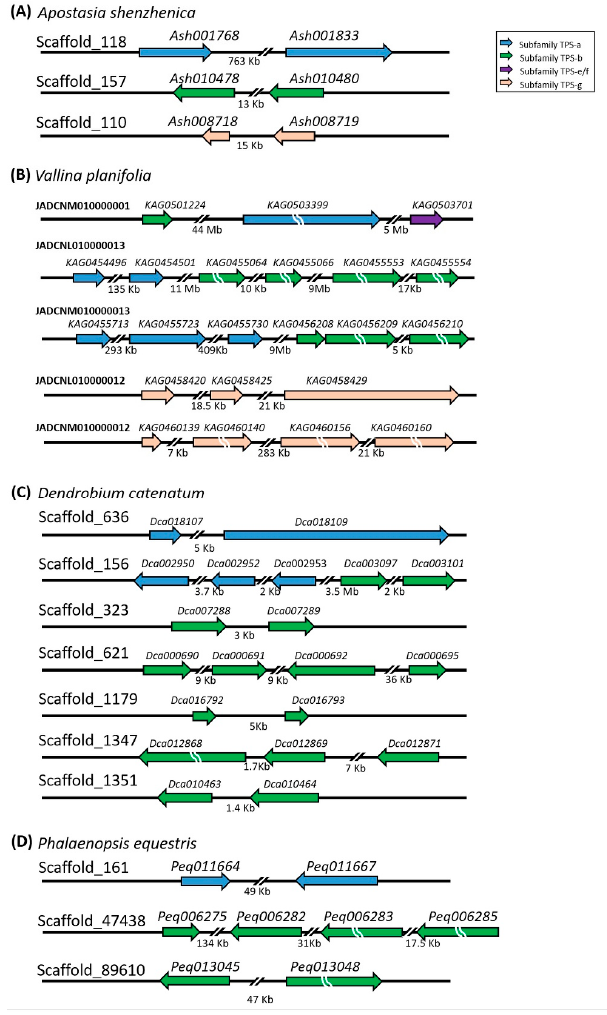
Figure 5. Gene clusters in Orchidaceae genome . Clustered genes in the genomic scaffolds of A. shenzhenica ( A ), V. planifolia ( B ), D. catenatum ( C ), and P. equestris ( D ), respectively. The TPS genes located on the scaffolds are identified from the assembled whole genome sequences of A. shenzhenica , V. planifolia , D. catenatum, and P. equestris . The direction of arrows illustrates the forward translation of genes in the scaffolds. Various colors indicate the distinct TPS subfamilies. Blue, green, purple, and bisque colors represent TPS genes in TPS-a , -b , -e/f , and -g subfamilies, respectively. Break lines indicate the shrink length of genes .